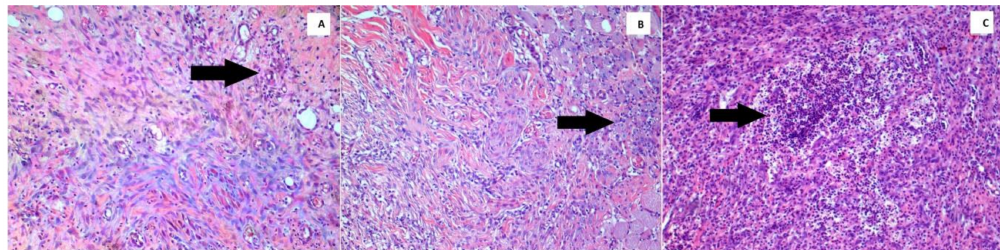
Figure 2. Histopathological images demonstrate the grade 1 ( A ), grade 2 ( B ), and grade 3 ( C ) inflammation severities in the wound (H&E, ×